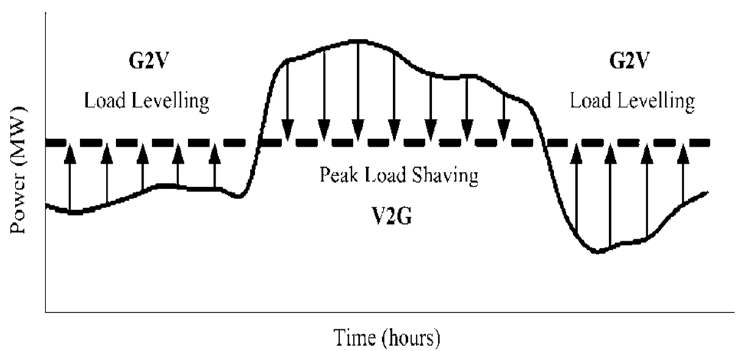
Figure 1. Peak shaving and load levelling example.